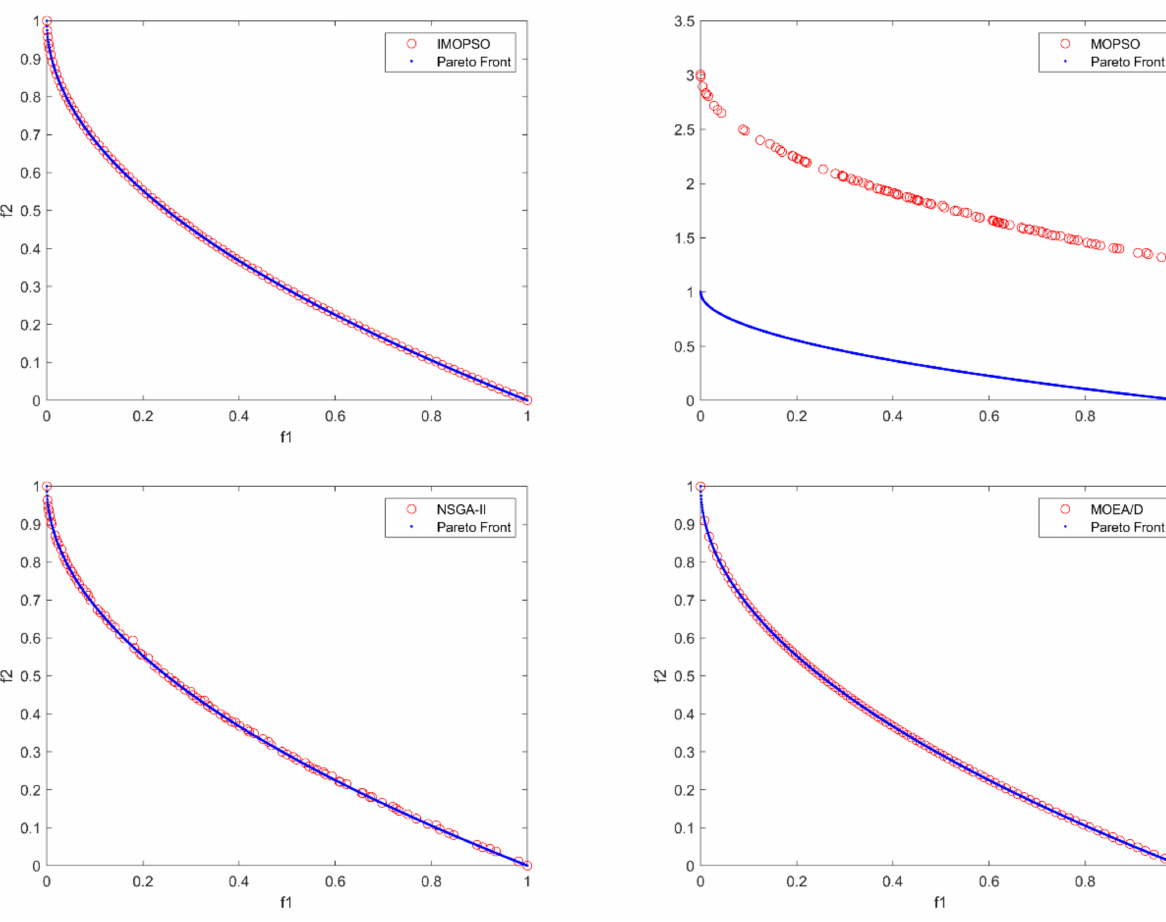
Figure 11. Comparison of the results of four algorithms for solving ZDT4